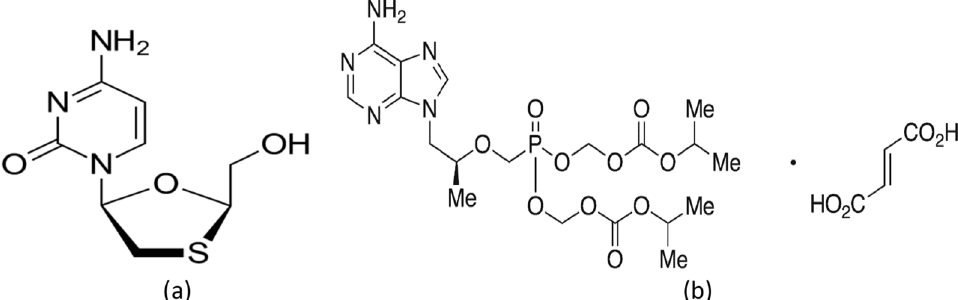
Fig. 1 Chemical structure of a lamivudine and b tenofovir disoproxil